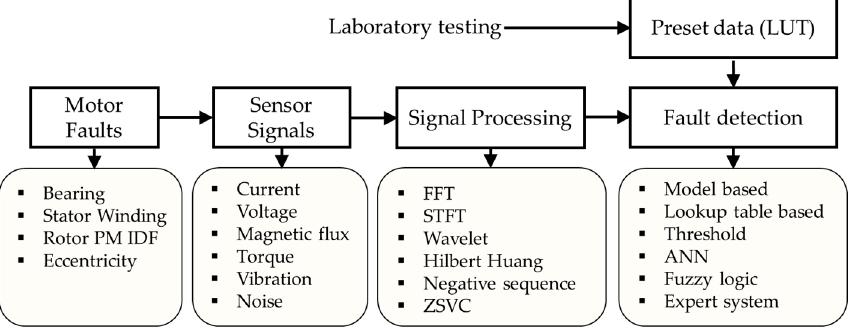
Figure 4. Block diagram of the various faults in the motor, signal used as the sensor, signal processing techniques, and the fault detection methods.